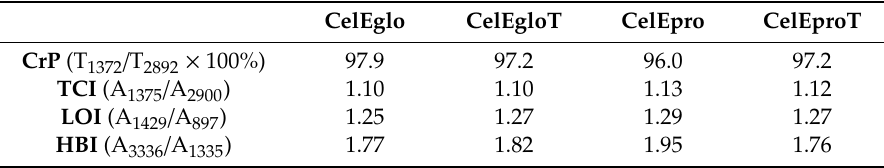
Table 5. Values of the indexes calculated from FTIR